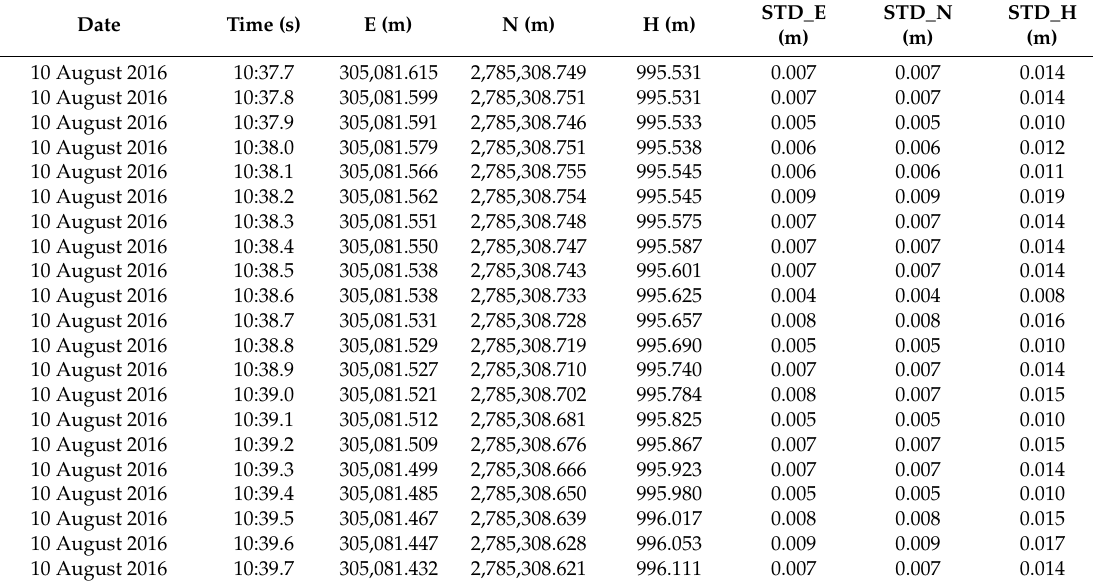
Table 3. Part listing of GNSS observations by PPK.